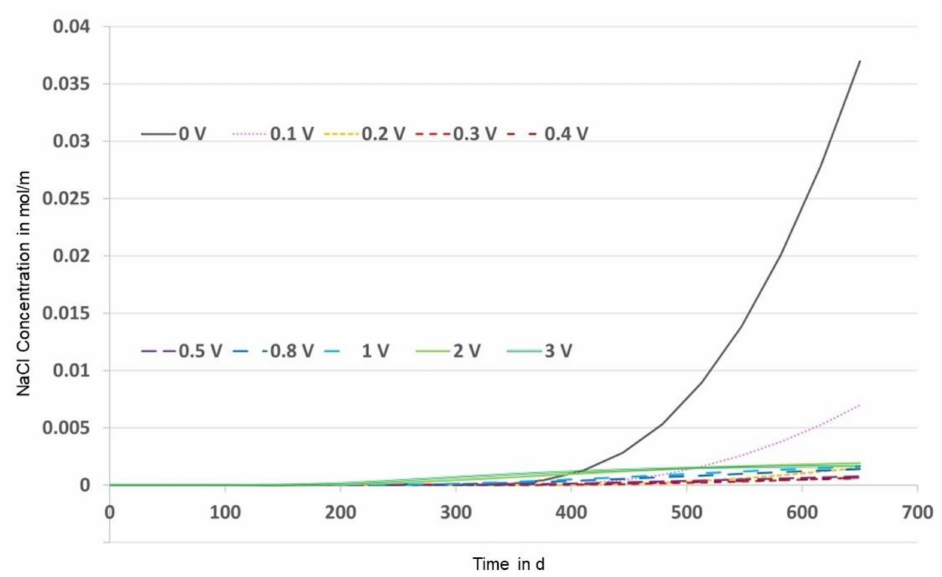
Figure 16. FEM solutions for the NaCl concentration over time at x = L (area III bottom).